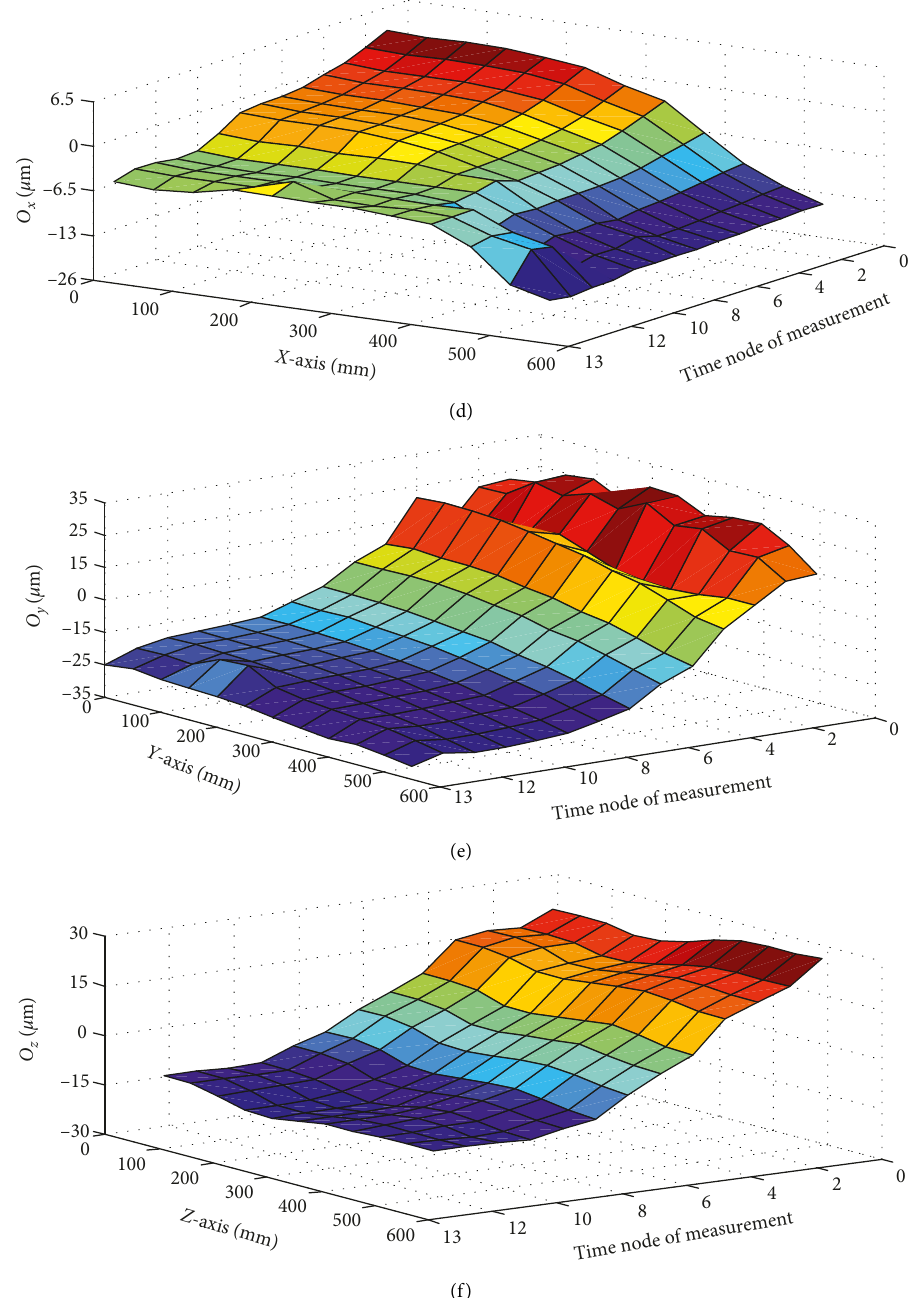
Figure 6: Distribution of the error vector with position and time. (a) Error vector P O x . (e) Error vector O y . (f) Error vector O z